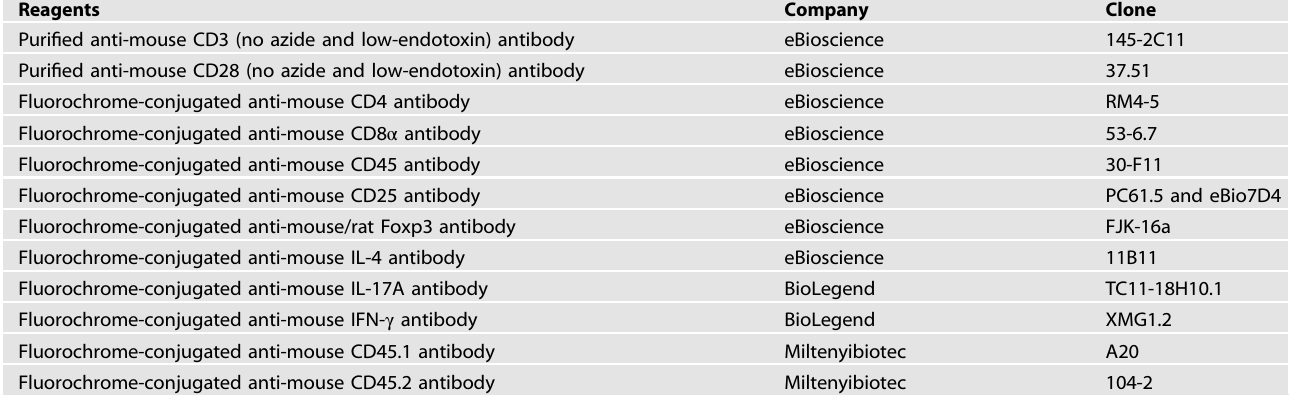
Table 1. The information of used